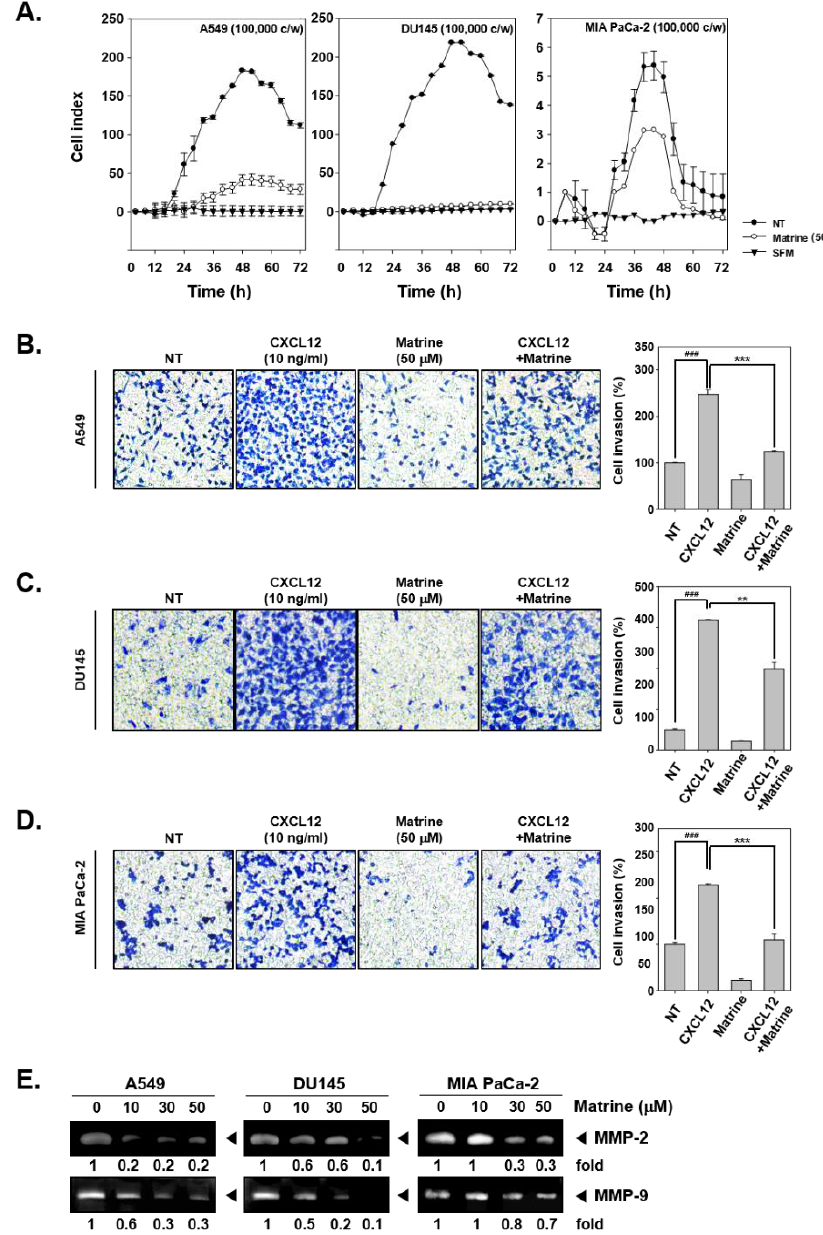
Figure 3. Matrine suppressed cell invasion in A549, DU145, and MIA PaCa-2 cells. ( A ) A549, DU145, and MIA PaCa-2 cells (1 × 10 5 cells / well) were seeded on matrigel-coated CIM (cellular invasion / migration)-Plate 16 then treated with matrine (50 µ M). Cell invasion activity was measured every 15 min intervals by Roche xCELLigence Real-Time CellAnalyzer (RTCA) DP instrument (Roche Diagnostics GmbH, Rotkreuz, Switzerland). ( B – D ) Membrane was coated with matrigel and dried for 1 h on room temperature. Membrane and chamber was combined, then cells were seeded on top chamber with CXCL12 (10 ng / mL) and matrine (50 µ M). Chamber was incubated in 37 ◦ C, 5% CO 2 incubator 6 h for A549 cells, 4 h for DU145 cells, and 5 h for MIA PaCA-2 cells. ( E ) Zymography was examined for determined gelatinase activity. A549, DU145, and MIA PaCa-2 cells (5 × 10 5 cells / well) were seeded on 6 well plate. Matrine was treated for 24 h and supernatant was obtained from each sample. Concentrated supernatant was prepared with equal amount of proteins. Then MMP-2 and MMP-9 gelatinase activity was compared on each cell lines. All experiments were performed independently at least 3 times and representative data are shown. ### p < 0.001, vs. non-treated (NT) cells and *** p < 0.001, ** p < 0.01 vs. CXCL12 + matrine treated